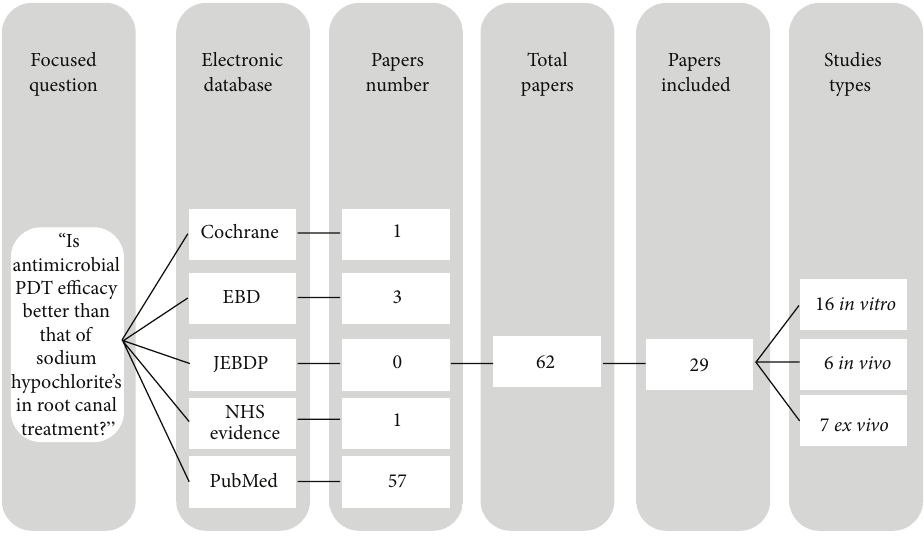
Figure 1: Identification of studies used in this narrative